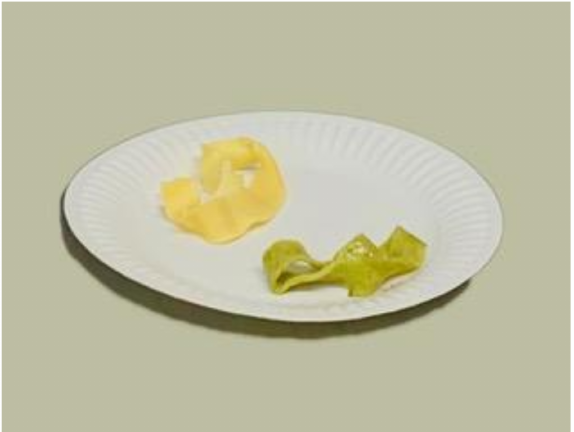
Figure 5. Control (non-enriched) and enriched pasta with H. portulacoides